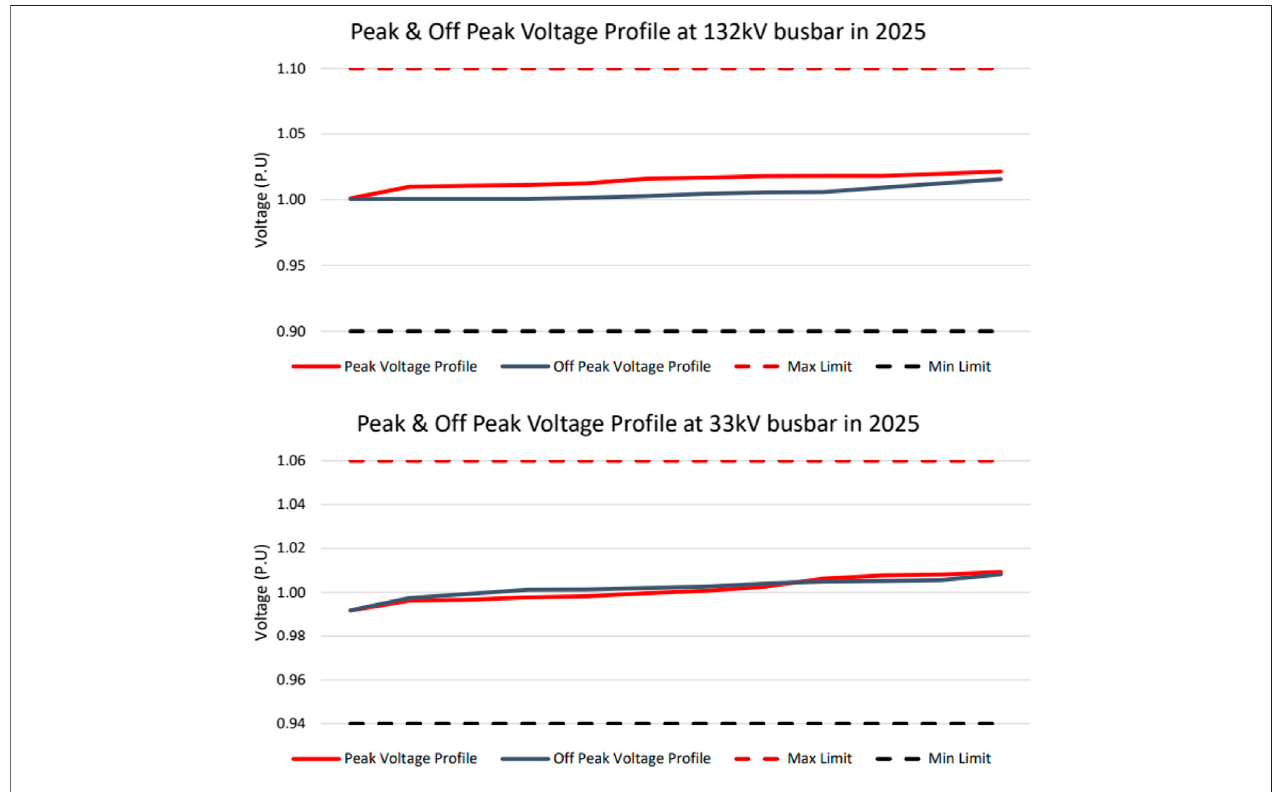
FIGURE 6 | DTS peak and off-peak voltage pro fi les at different power grids in 2025.